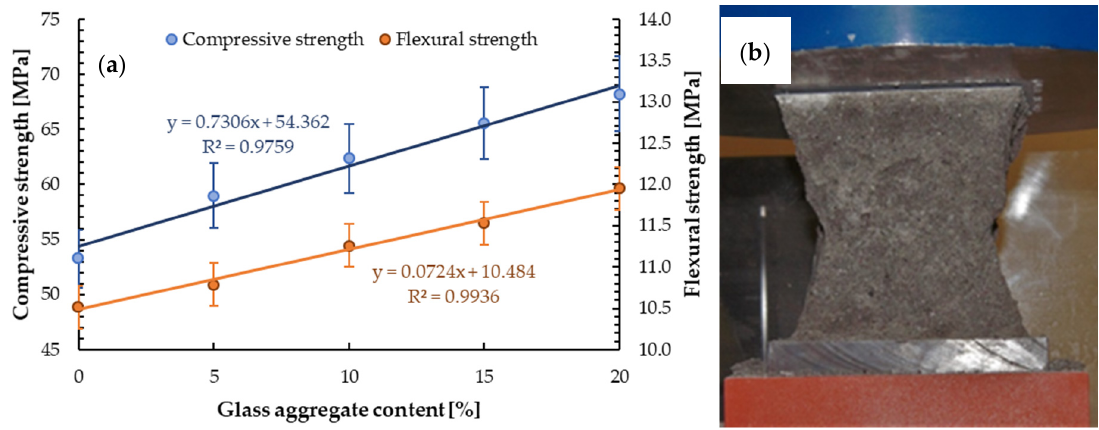
Figure 8. ( a ) Compressive and flexural strength depending on GSA ratio, ( b ) sample destruction.